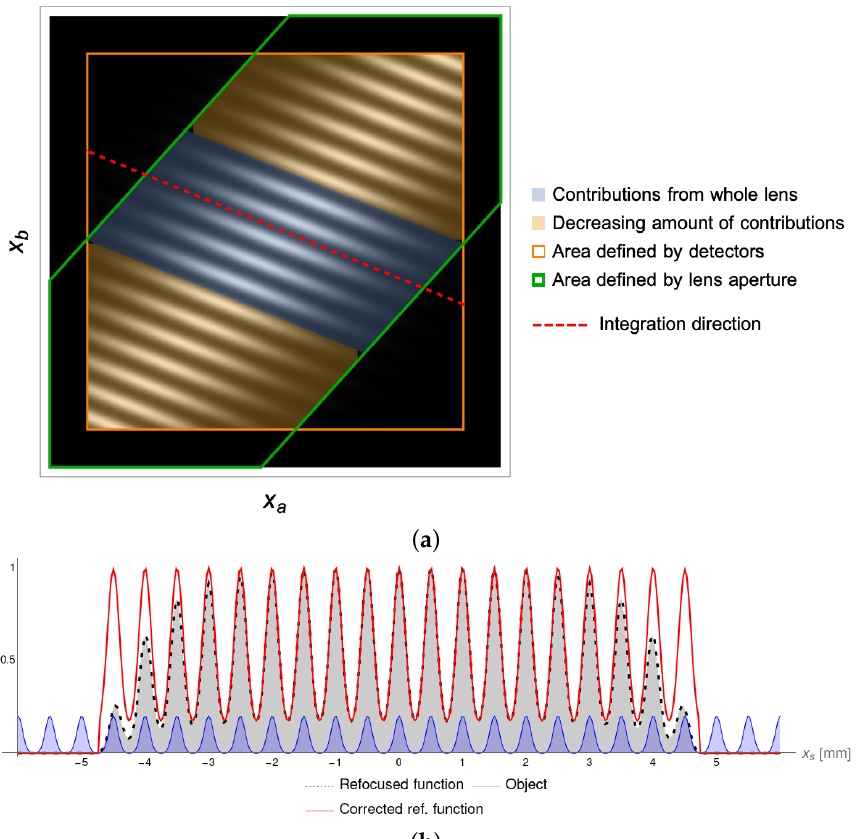
Figure 4. ( a ) Subdivision of the correlation function into parts characterized by different properties. The strip enclosed between the two green lines is the area defined by the lens aperture, and the squared area defined by the orange line identifies the space defined by the size of two detectors. The correlation function can only be measured in the region defined by the overlap of the two. The red dashed line identifies the integration direction, namely, the direction along which the correlation function contains information about the detail located at coordinate x s on the object plane. As the integration line sweeps the entire object plane (i.e., all possible values of x s ), two cases can occur: either the same detail receives contributions from the whole lens or, due to the finite size of the detectors, contributions decrease towards the edges. ( b ) Effect of the finite size of the lens and the detectors on the reconstruction of the object. The solid blue line represents the reference object, in arbitrary units. Points of the correlation function located close to the edge of the detectors area (red area in ( a )) give rise to artifacts in the reconstructed object (black dashed line), due to the varying amount of contributions received by the corresponding object details. Artifacts can be removed by applying the correction discussed in the text Equation (16), so that all the slits within the field of view can be reconstructed (solid red line) with their correct relative